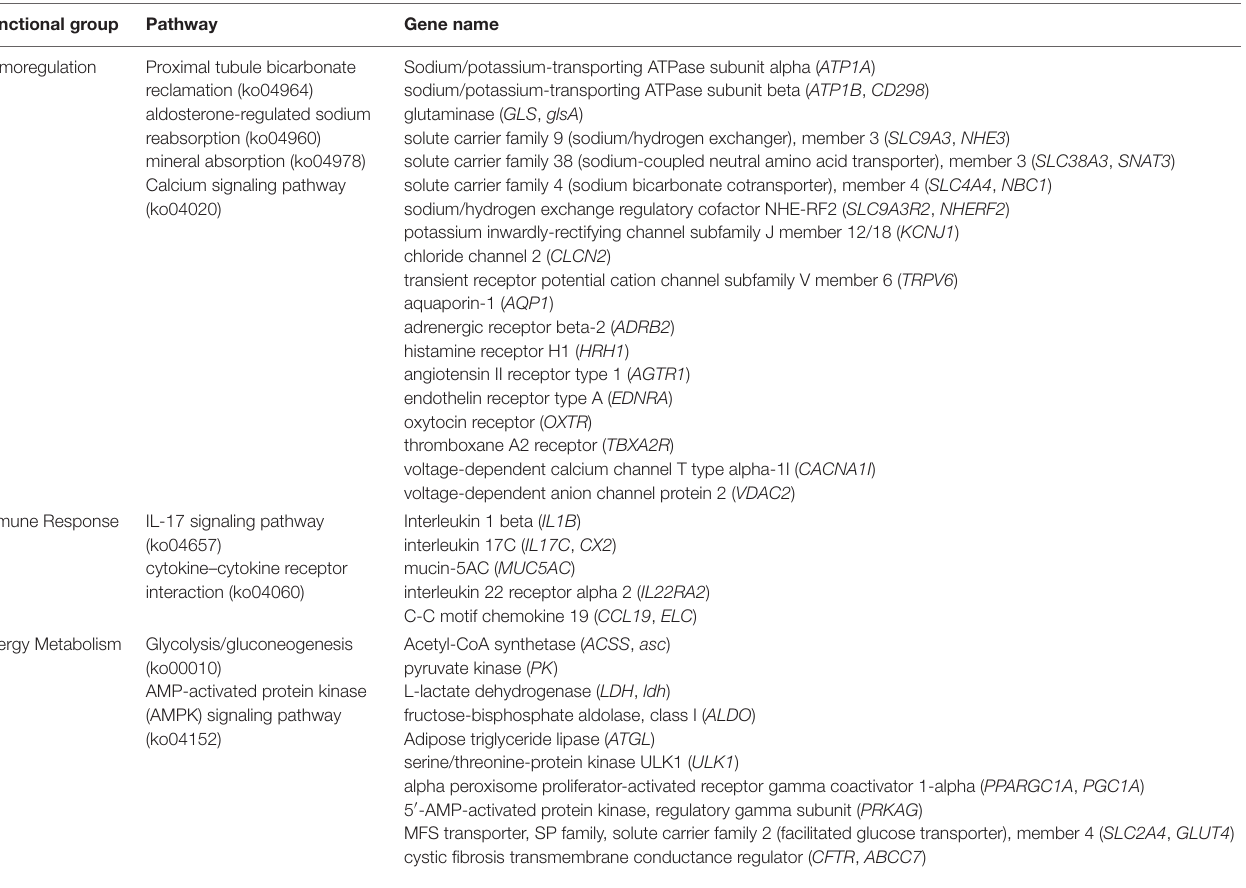
TABLE 7 | Enriched DEGs may be related to osmotic adjustment, immunity, and energy metabolism. Functional group